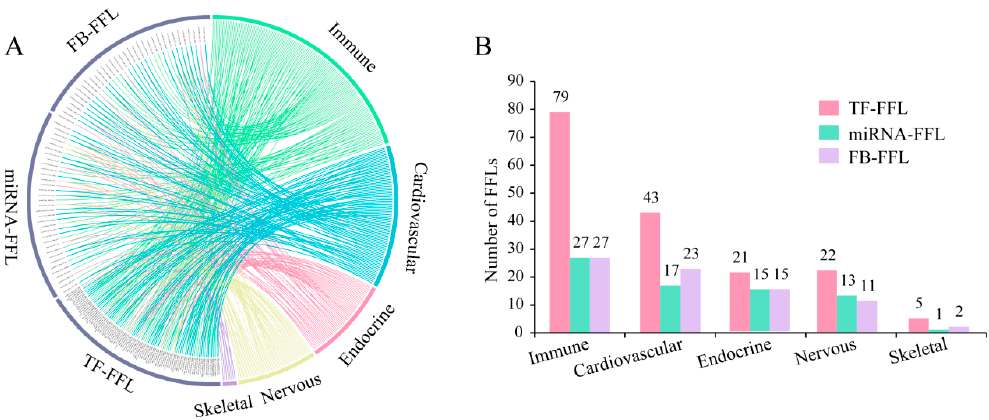
Figure 2. System function-related FFLs. ( A ). System function-related FFLs in five systems including immune, cardiovascular, endocrine, nervous and skeletal systems, which encoded by green, blue, red, yellow and purple, respectively. Edges connect the FFLs with the functions of body systems. ( B ). Number of dysregulated TF-FFLs (red), miRNA-FFLs (green) and FB-FFLs (purple) in microgravity for five human body systems.